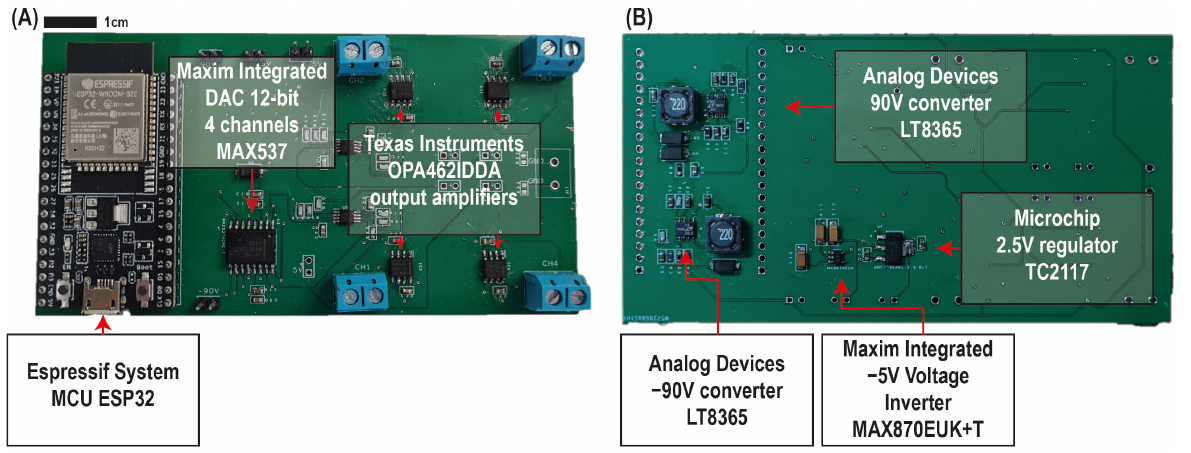
Figure 4. The developed PCB: frontal ( A ) and rear ( B ) view. High-voltage and low-voltage regulators have been located in the bottom layer of the PCB. The MCU, DAC, and amplifiers have been located in the top layer of the PCB.